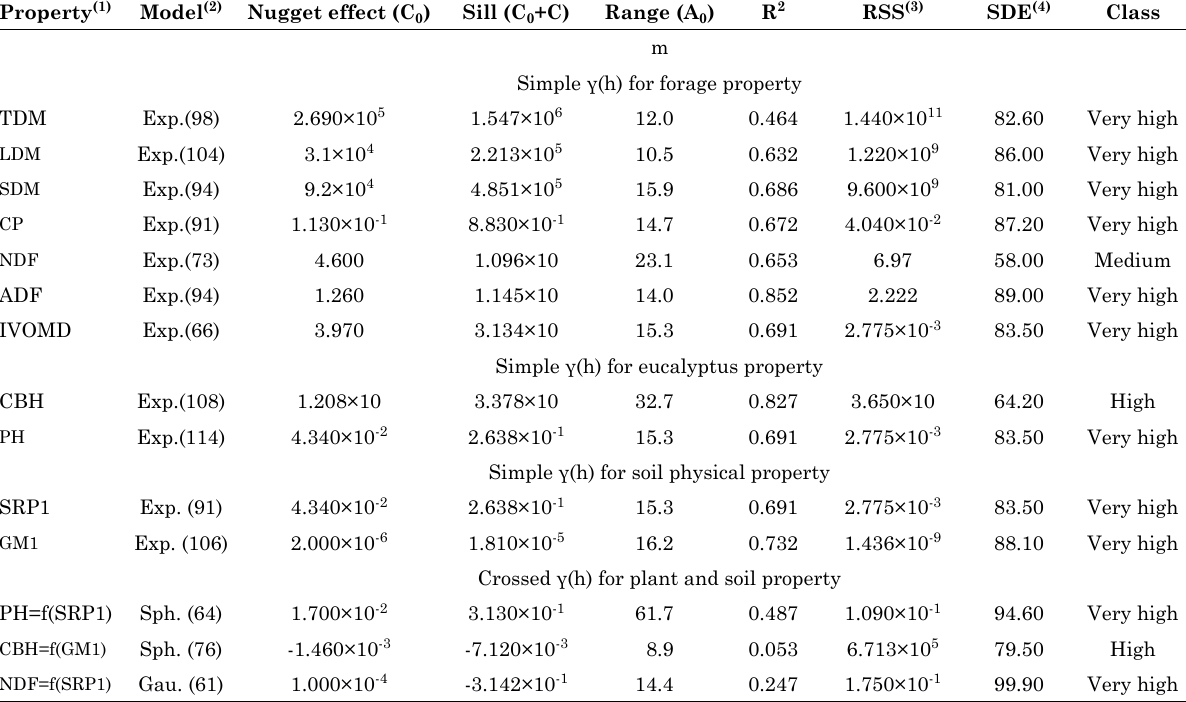
Table 3. Parameters of single and cross semivariograms fit for some dendrometric properties of Eucalyptus urograndis , yield and bromatological properties of forage, and physical properties of a Quartzipsamment (Entisol) soil in a silvopastoral system in Ribas do Rio Pardo, MS, Brazil Property